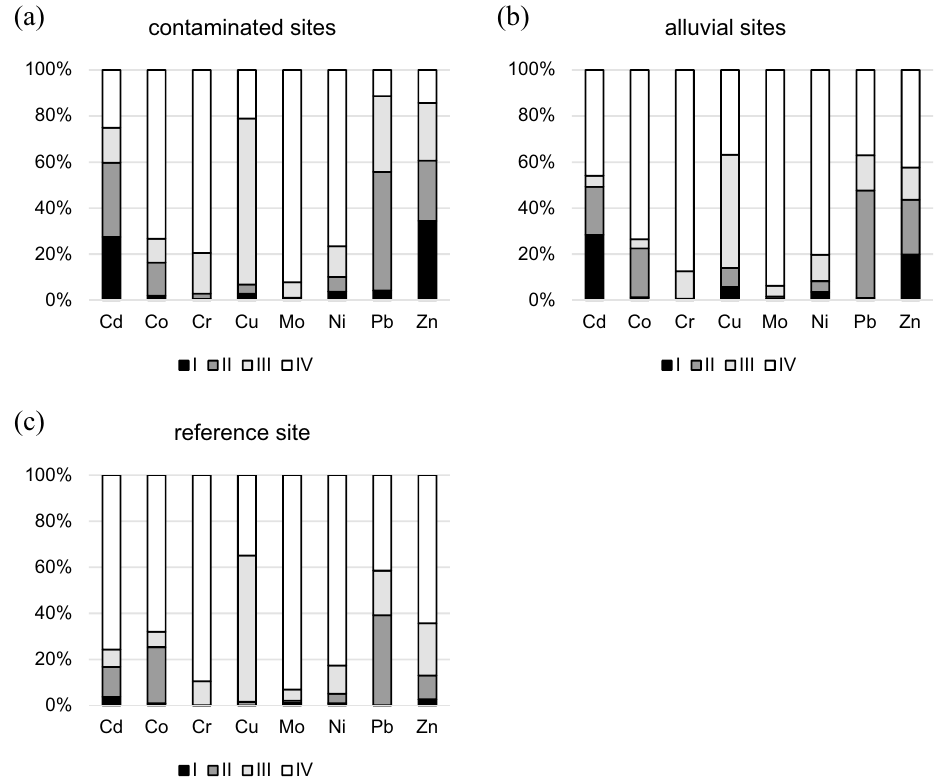
Figure 2. Distribution of potential toxic elements in 4 fractions in the soil depth of 0–10 cm. I exchangeable and weak acid soluble fraction, II reducible fraction, III oxidisable fraction, IV residual